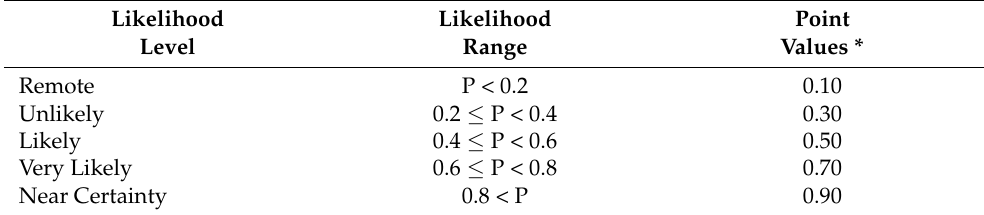
Table 6. Likelihood of risk factors